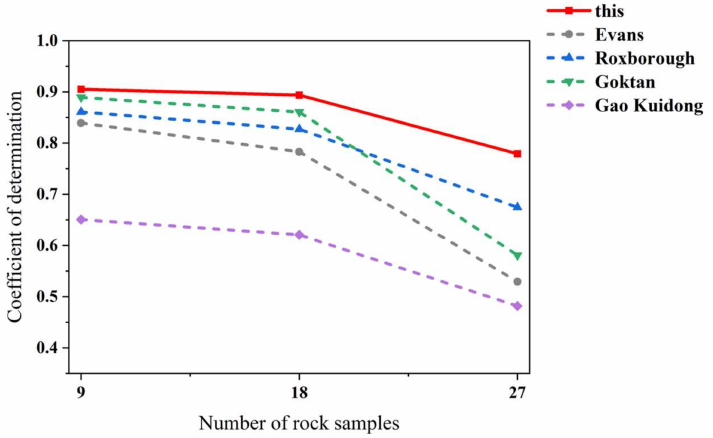
Figure 8. Line graph reflecting the change in the coefficient of determination in the three analyses. In addition, the root mean square error (RMSE) between the theoretical results and the experimental results is calculated separately to evaluate the accuracy of the theoretical model prediction. As shown in Table 9 and Figure 9, for 27 rock samples the RMSE of the theoretical model proposed in this paper is the lowest of 11.74 followed by the Goktan semi-empirical model with RMSE of 11.81, while Evans model has the highest RMSE of 19.10. Table 9. Root mean square error of each theoretical model.